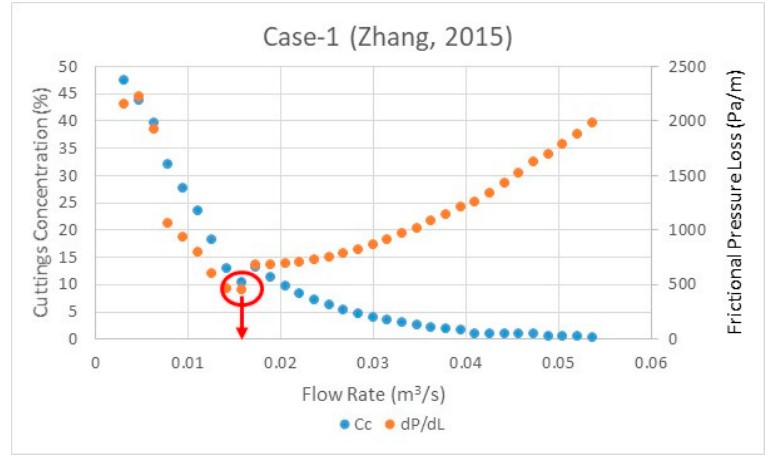
Figure 5. A sample analysis conducted to determine the optimal flow rate using Zhang’s model when the pipe rotation speed is 0 1/s.